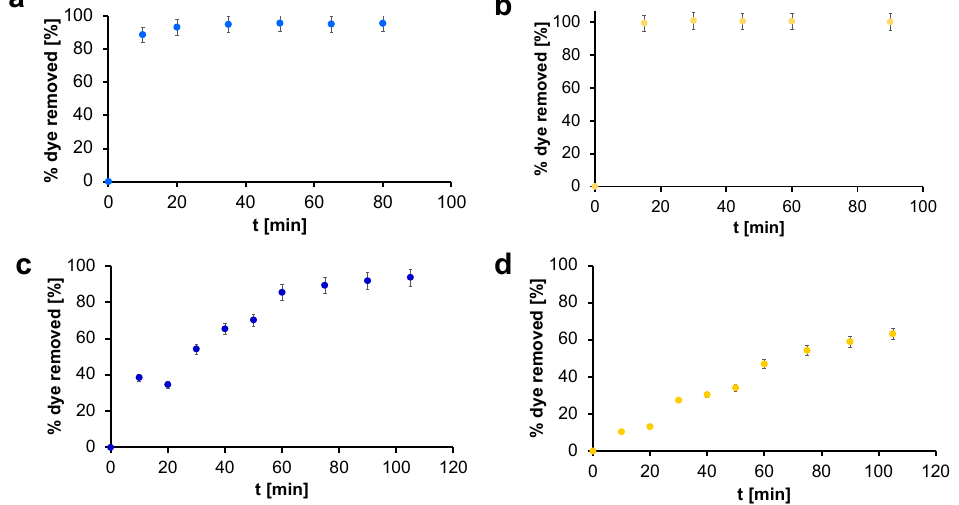
Figure 6. Percentage of removed dyes for GO-CS AG with IC (blue dots) and CBY (yellow dots) in different concentrations: ( a ) IC 100 mg/L, ( b ) CBY 100 mg/L, ( c ) IC 350 mg/L, and ( d ) CBY 350 mg/L.